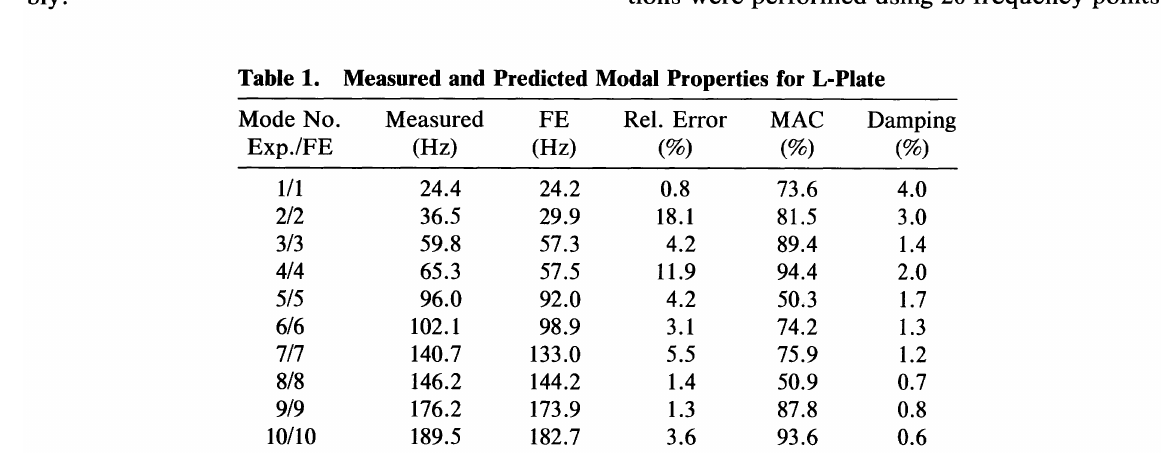
Table 1. Measured and Predicted Modal Properties for L-Plate Mode